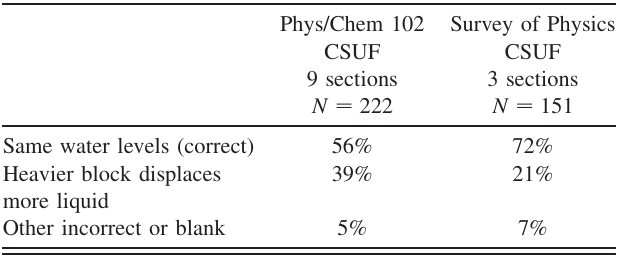
TABLE I. Student responses to the water displacement problem (Fig. 1).